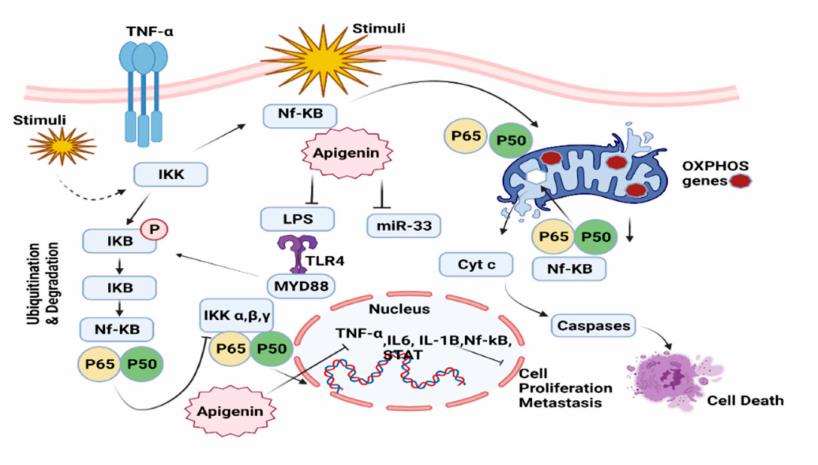
Figure 4. Downregulation of NF-kB pathway by